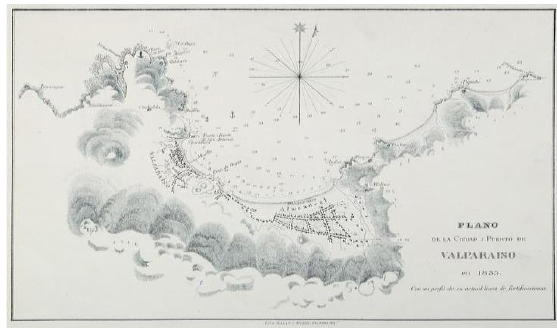
Figure 1. Valparaíso plan 1835. Mapoteca Archivo